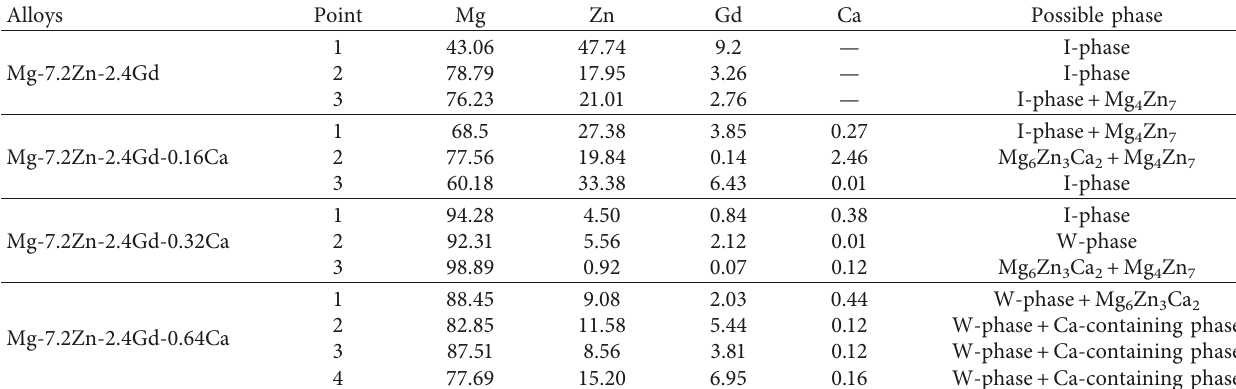
Figure 3: SEM images of the as-cast Mg-Zn-Gd(-Ca) alloys: (a) Mg-7.2Zn-2.4Gd, (b) Mg-7.2Zn-2.4Gd-0.16Ca, (c) Mg-7.2Zn-2.4Gd- 0.32Ca, and (d) Mg-7.2Zn-2.4Gd-0.64Ca. Table 1: EDS result of the as-cast